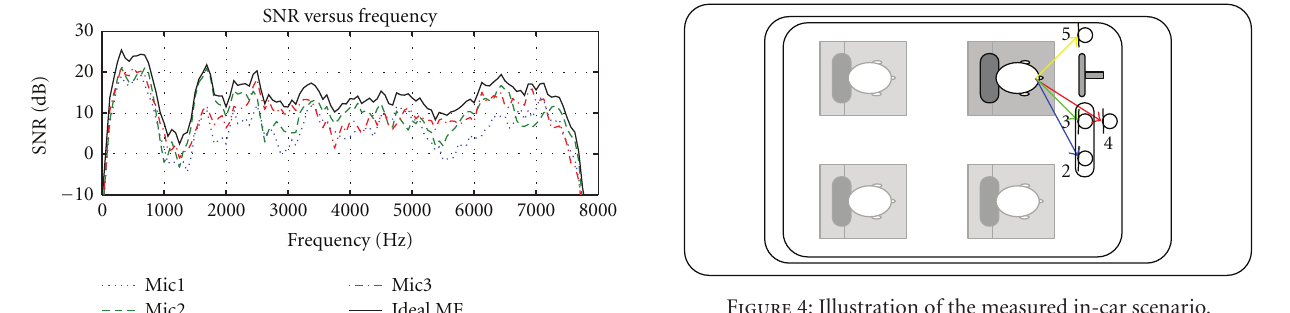
Figure 4: Illustration of the measured in-car